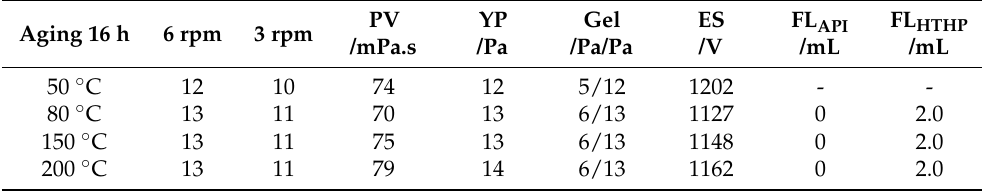
Table 3. Performance of oil-based drilling